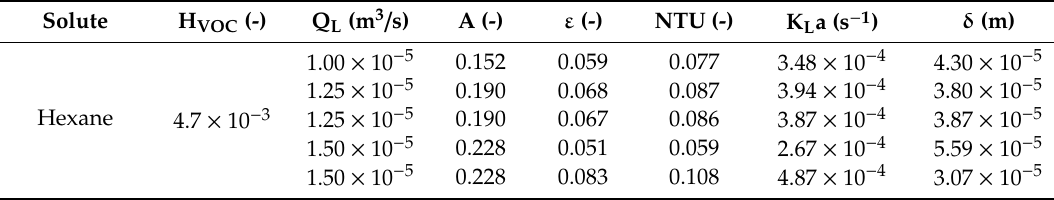
Table 4. K L a determination using the data reported in Bourgois et al. [6]. For all the experiments,